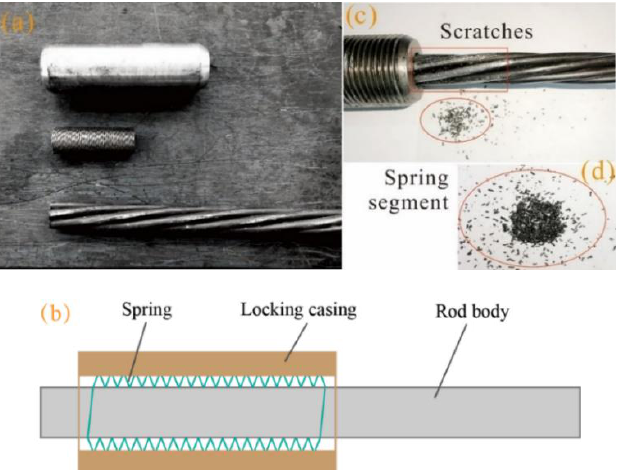
Figure 12. Tail structure of the flexible bolt and the situation where the locking casing is pulled out: ( a ) the components of the tail structure of flexible bolts, ( b ) a cross-sectional view of the tail structure after extrusion, ( c ) the failure mode when locking casing is pulled out, and ( d ) spring segments.